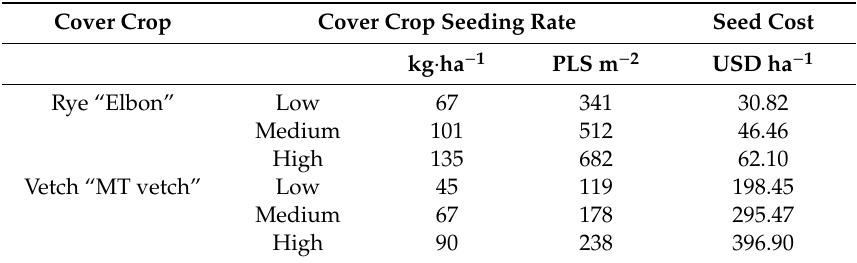
Table 2. Cultivar, seeding rates in kg · ha − 1 and pure live seeds m − 2 (PLS), and seed cost in USD ha − 1 for cereal rye (rye) and hairy vetch (vetch) cover crops. Cover Crop Cover Crop Seeding